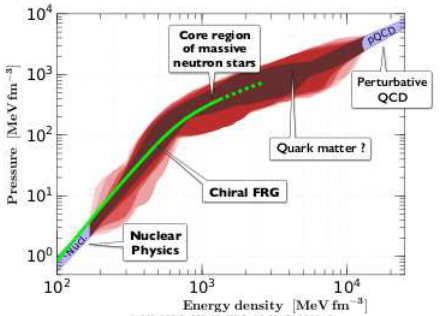
Figure 4. Equation-of-state P ( ε ) covering neutron star matter and beyond, with low-density constraints from nuclear physics [18–20], asymptotic constraints from perturbative QCD and uncertainty bands interpolating between these extremes (adapted from [29]). Also shown is an EoS curve derived from chiral nucleon-meson fi eld theory combined with functional renormalization group methods (Chiral FRG) [21].